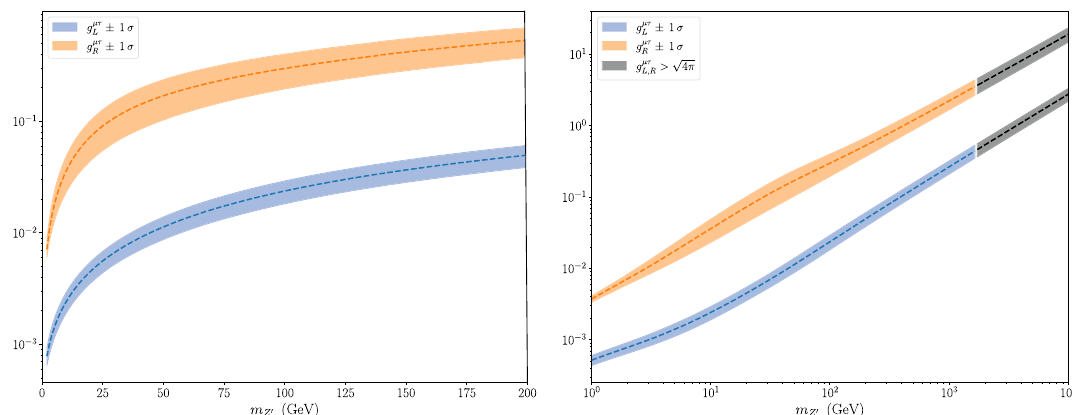
μτ ; the dashed lines denote the best fit value of the couplings for a L ( R )